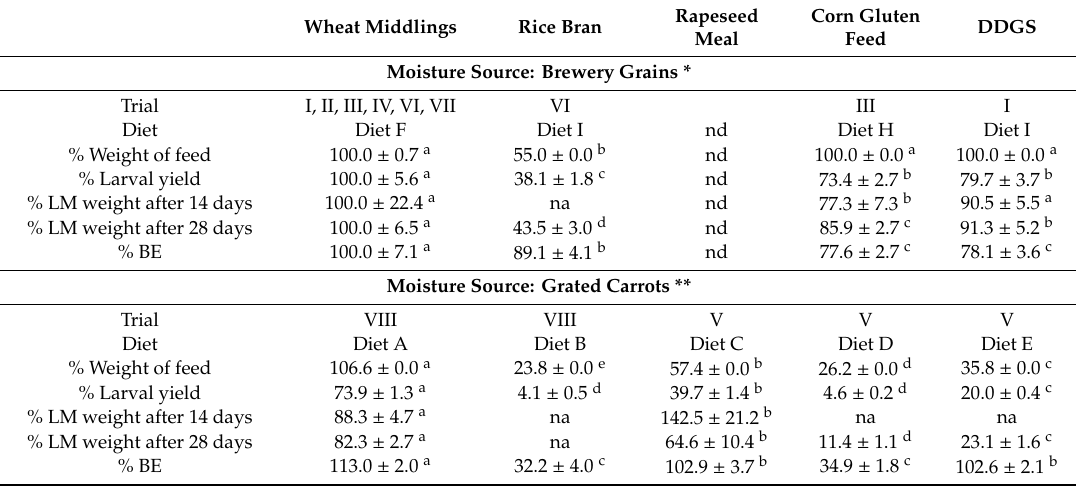
Table 3. Parameters on growth performance related to experiments performed on pure side-streams, expressed as relative values (%) compared to the reference diet F ( n = 8). Rapeseed Wheat Middlings Rice Bran